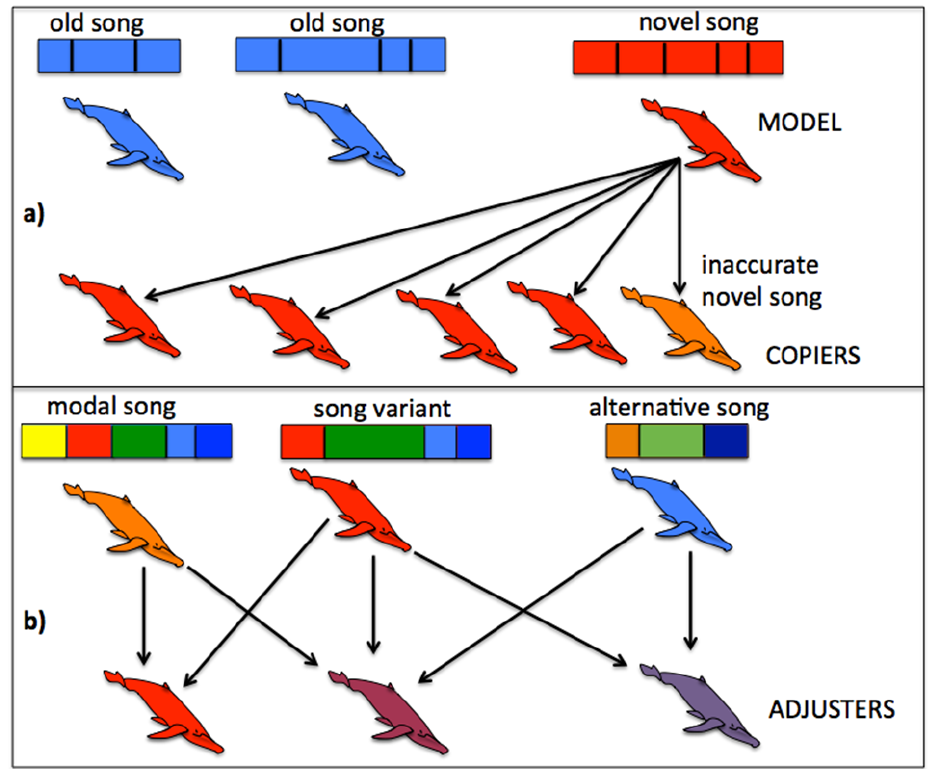
Proposed Processes that May Drive Concerted Changes in Humpback Whale